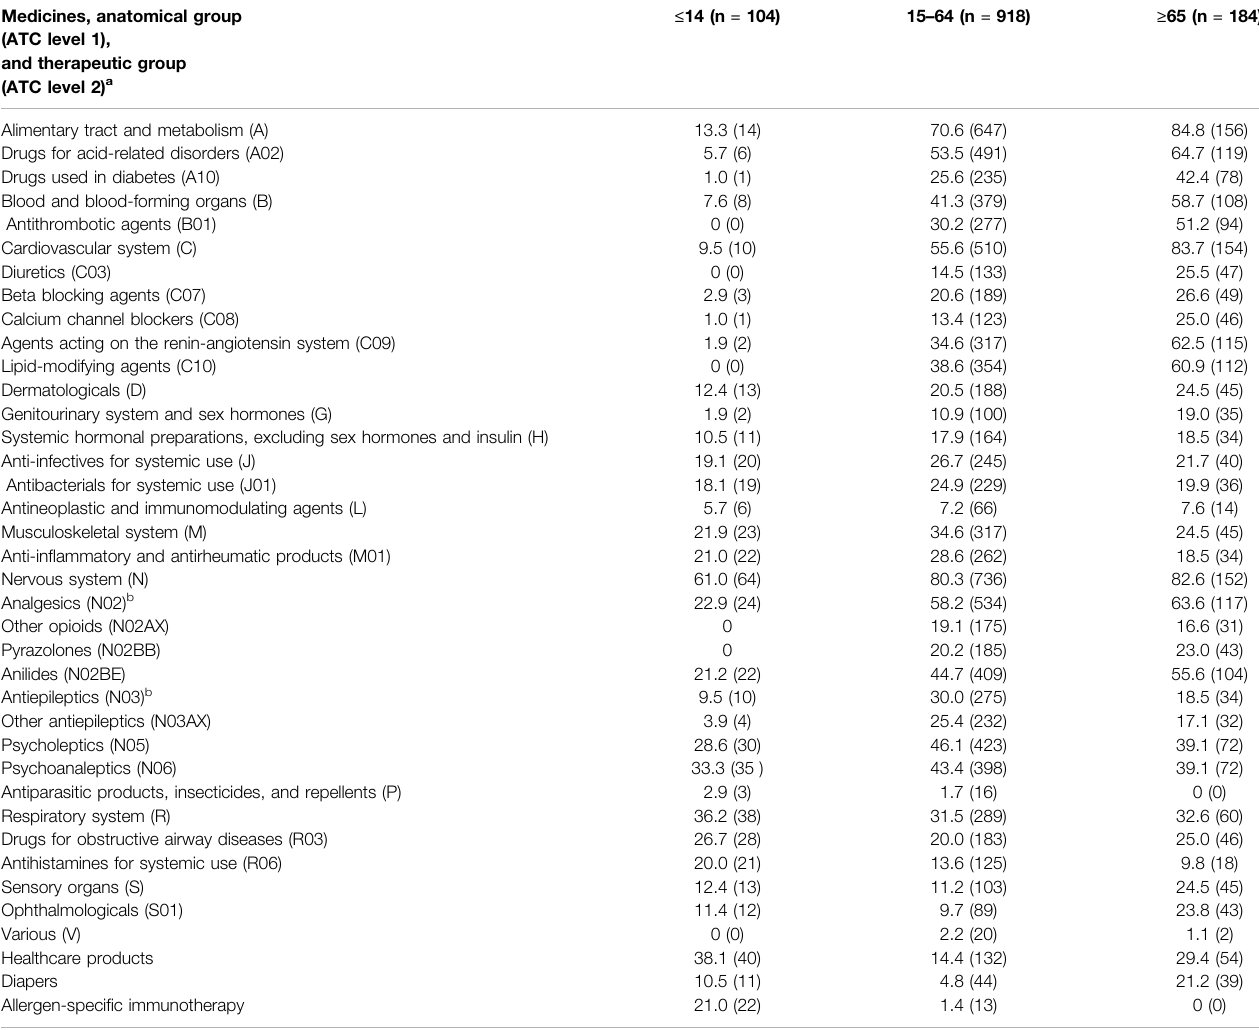
TABLE 3 | Proportion of bene fi ciaries that received at least one medicine or healthcare product for age groups, % (N). Medicines, anatomical group (ATC level 1), and therapeutic group (ATC level 2)